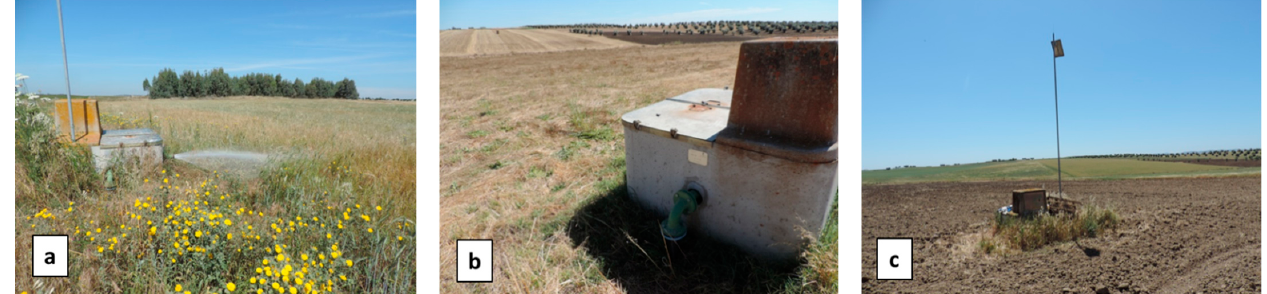
Figure 11. Pictures in May 2019 of ( a ) hydrant H5.6, ( b ) hydrant H10, ( c ) hydrant H11 and the corresponding environment, respectively, a meadow with high grass, a meadow with short dry grass, and bare soil. The picture in ( a ) was taken while the valve was open to simulate a leak. The MAV flights in May and September were performed at 1200 m altitude, leading to a Ground Sample Distance (GSD) of 0.42 m and 0.73 m for the multispectral and thermal infrared cameras, respectively. The flight lines during the 16 May operation and